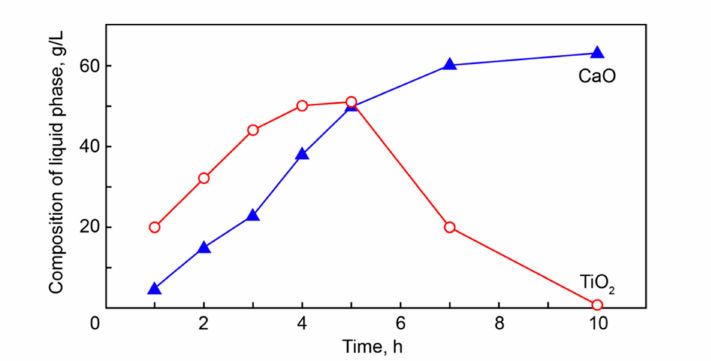
Figure 4. Change in Ti and Ca contents in concentrated hydrochloric acidic solution with